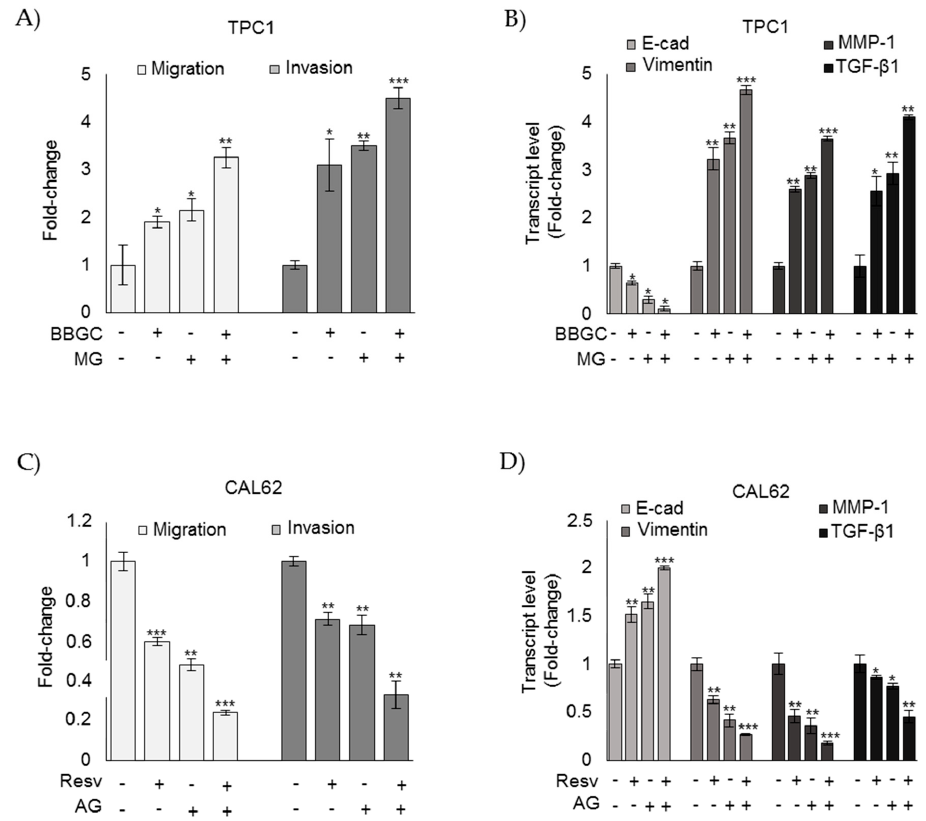
Figure 5. Methylglyoxal (MG) sustains the aggressive phenotype of ATC CAL62 cells. Papillary thyroid cancer TPC1 and anaplastic thyroid cancer CAL62 cells grown to confluence under standard conditions were analyzed by specific assays or real-time PCR to evaluate their migration and invasion capabilities ( A , C ) or the mRNA expression of E-cadherin (E-cad), Vimentin, MMP-1, and TGF- β 1 ( B , D ), respectively, as described in the Materials and Methods section. The histograms indicate mean ± SD of three different cultures, and each was tested in triplicate. mRNA expression levels were normalized to the amount of an internal control transcript ( β -actin). Invasion/migration capabilities as well as gene expression were measured in TPC1 after 5 µ M MG administration and in CAL62 cells after 1 mM aminoguanidine (AG), both for 48 h. The histogram indicates mean ± SD of three di ff erent cultures, and each was tested in triplicate. * p < 0.05; ** p < 0.01; *** p <